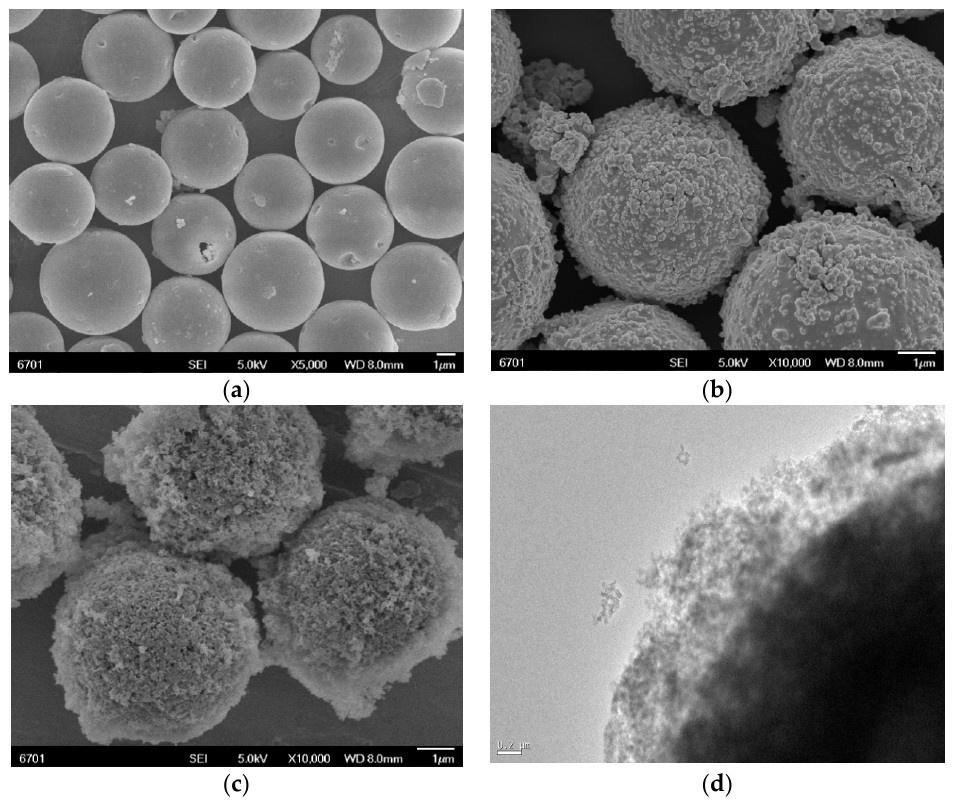
Figure 1. SEM images of the silica particles: ( a ) original silica particles; ( b ) CPM1; ( c ) CPM2 and ( d ) TEM images of CPM2.